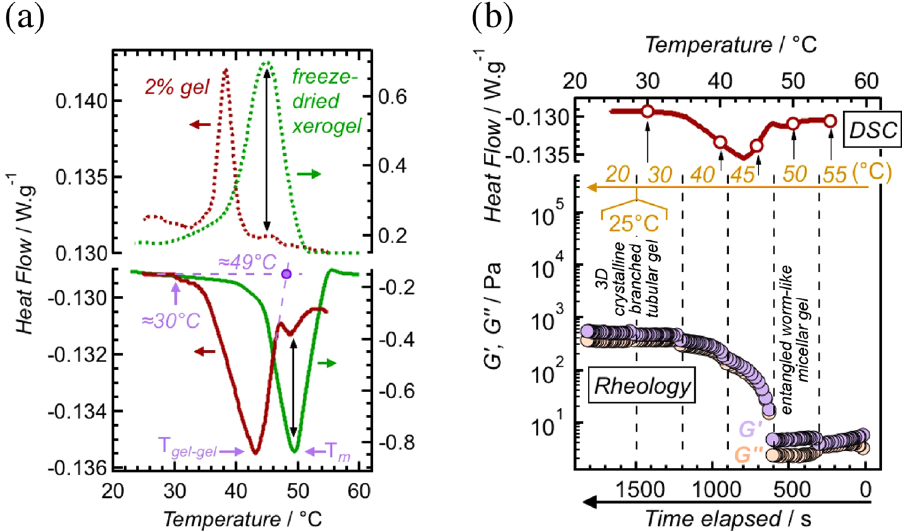
Figure 3. DSC and rheology data of 2% pH = 5.37 system. ( a ) DSC of the hydrogel and the corresponding freeze-dried xerogel (cooling/heating rate = 2 °C/min). The starting-point ( ≅ 30 °C) and the estimated end- point ( ≅ 49 °C) of the gel-to-gel transition were marked. ( b ) The combined DSC data (taken from Fig. 3a) and dynamic rheological data (strain = 2%; ω = 10 rad/s) of the hydrogel, where the temperature of the sample was lowered from 55 °C to 20 °C in a stepwise fashion (the waiting time between temperature changes was 300 s).